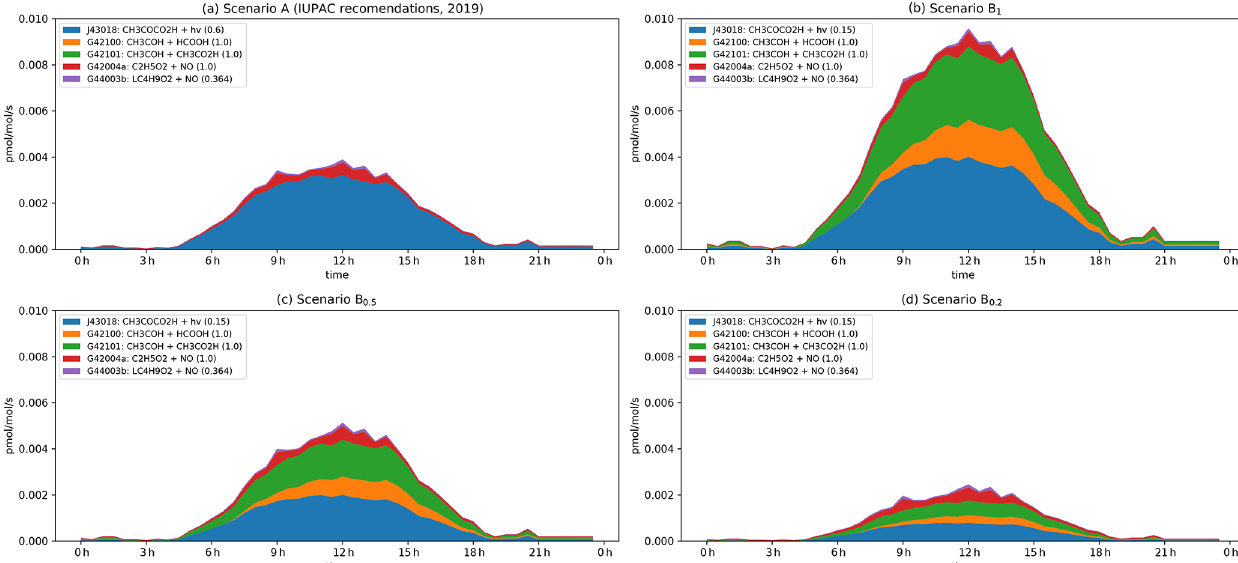
Figure 6. Modelled rates of CH 3 CHO formation (in pptvs − 1 ) through the diel cycle from photolysis of pyruvic acid (blue, orange, and green) and other reactions during IBAIRN. (a) Scenario A (IUPAC). (b) Scenario B 1 . (c) Scenario B 0 . 5 . (d) Scenario B 0 . 2 . In the legend, the first term is the equation tag used by CAABA/MECCA for the reaction. LC4H9O2 is the peroxy radical formed in the reaction of OH with butane. A full listing of the reactions can be downloaded (see Data availability